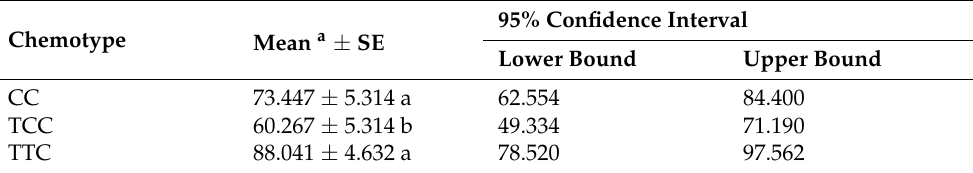
Table 2. Adjusted estimated marginal (EM) means of the mortality of Calliphora vomitoria adults exposed to the essential oils extracted from different oregano chemotypes.